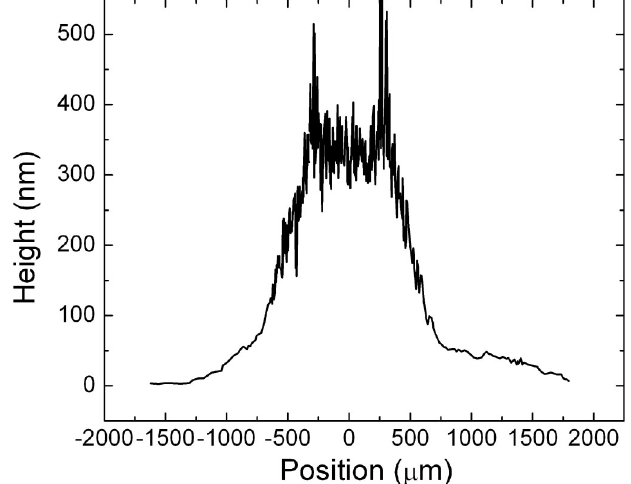
FIG. 7. Surface profilometry of the central damage area indi- cates the presence of significant surface roughening. Because of the large tip size, the profile data should be interpreted as sampling the local maxima of the surface